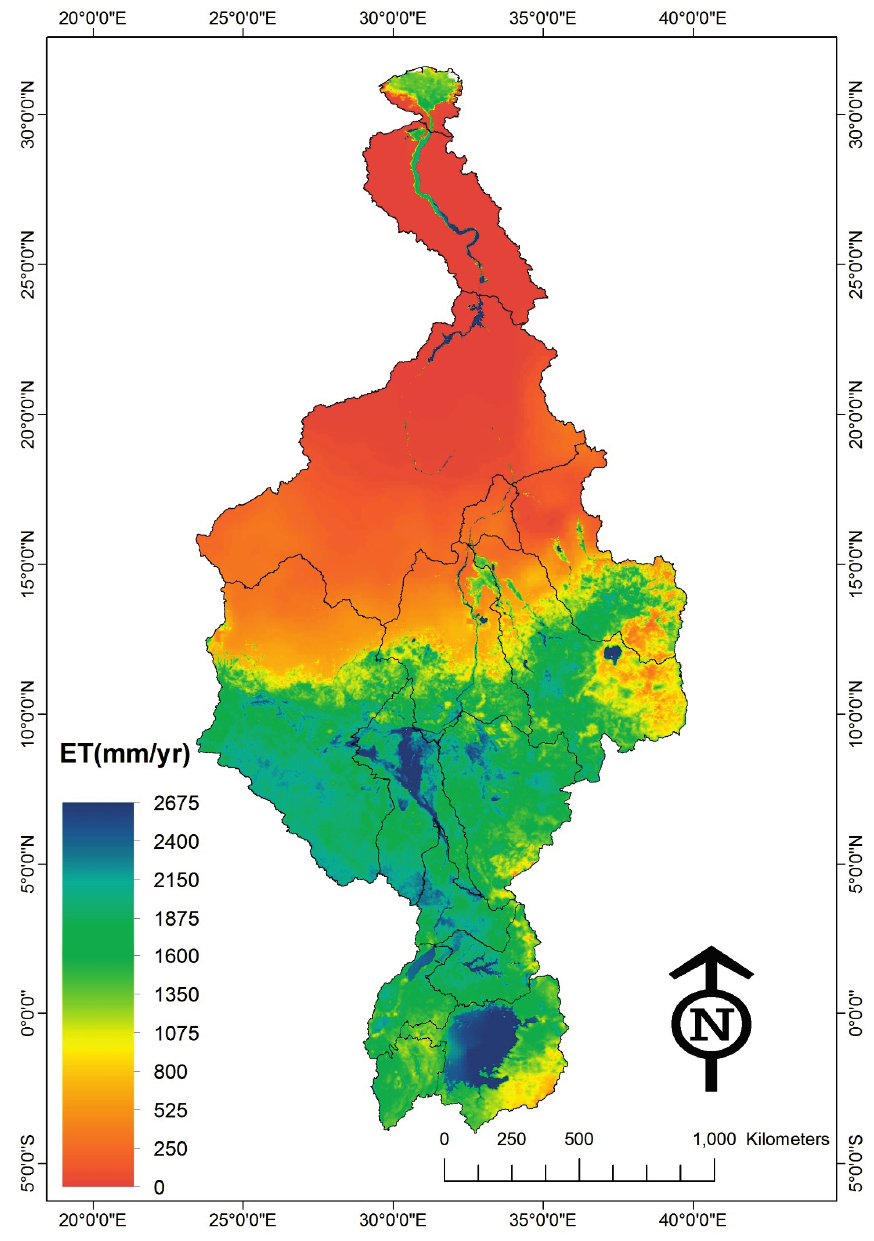
Figure 4. Distribution of the annually accumulated actual evapotranspiration across the Nile basin averaged for the period 2005–2010. The pixel size is 1 km. The data are based on SSEBop being calibrated against ETLook and adjusted for interception